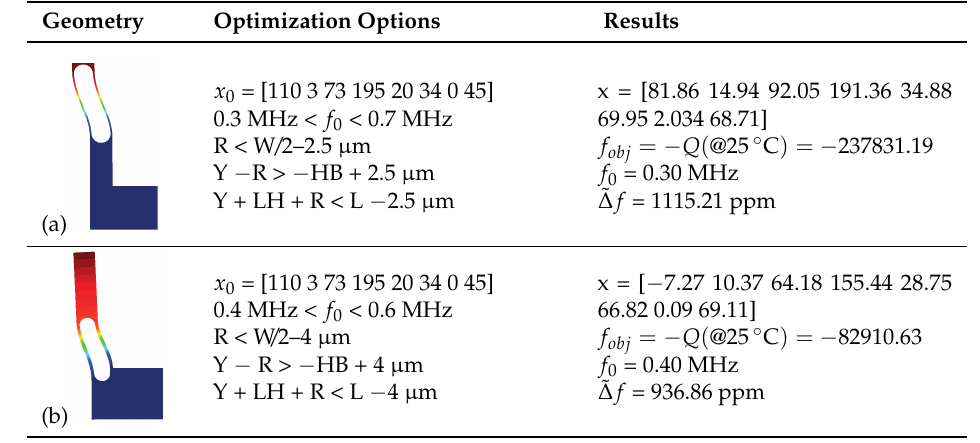
Table 3. Optimal geometries computed through the CMA-ES optimization algorithm starting from the geometry shown in Figure 9. The employed objective function reads: f obj = − Q ( @25 ◦ C ) . All the geometric dimensions are reported in µ m and the angles in degrees.